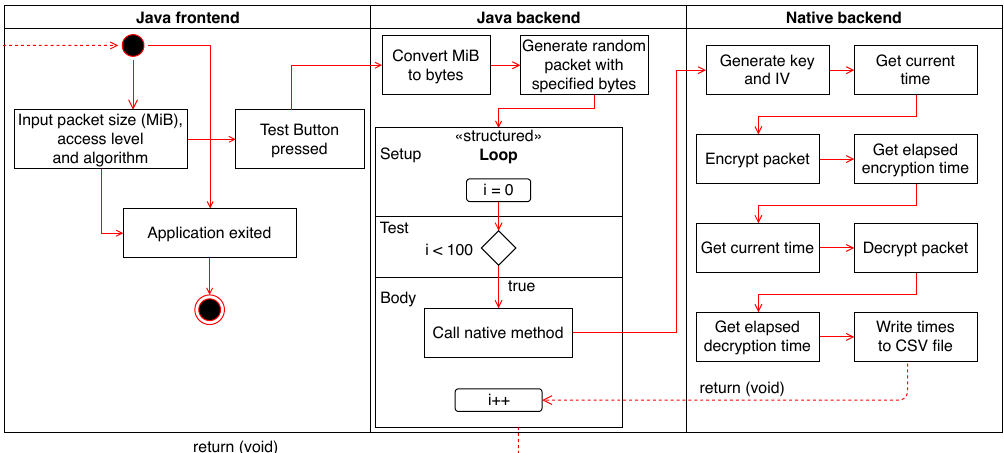
Figure 3. Application flow